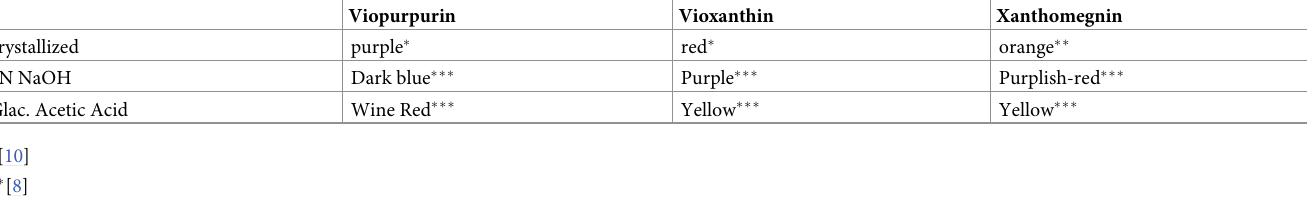
Table 3. Comparison of the three main pigments of T . rubrum